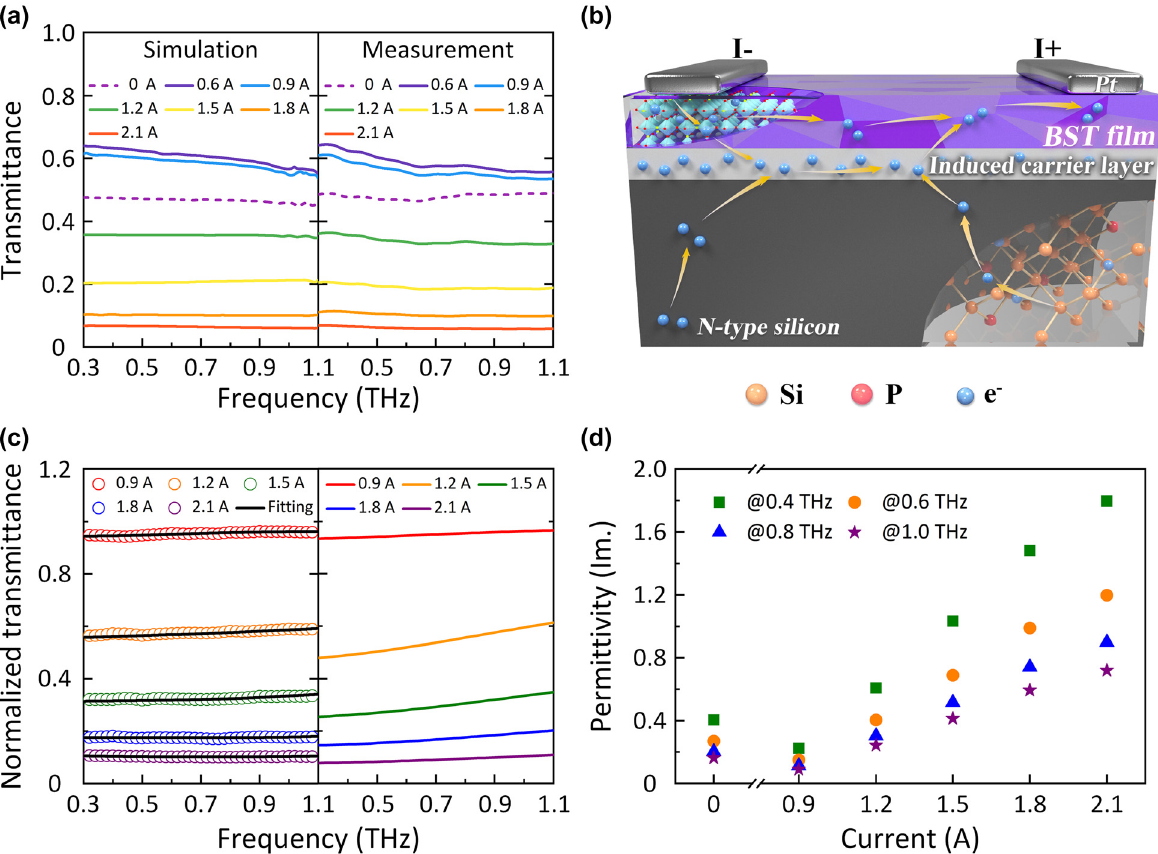
Figure 4: Current tuning mode (a) Simulated and measured transmittance of the hybrid meta-modulator under different currents. (b) Oper- atingschematicdiagramof the meta-modulator underthecurrent tuning mode.(c) Measured(circle), fitted(solidblack curve) andtheoretical (coloredsolidcurve)valuesofthenormalizedtransmissionamplitudeas afunctionoffrequencyatbiascurrentsof0.9,1.2,1.5,1.8,and2.1A. (d) Current intensity dependence of the imaginary part of the effective permittivity for our design at different